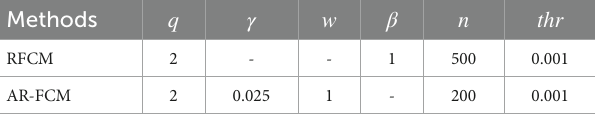
TABLE 1 RFCM and AR-FCM parameter setting table.